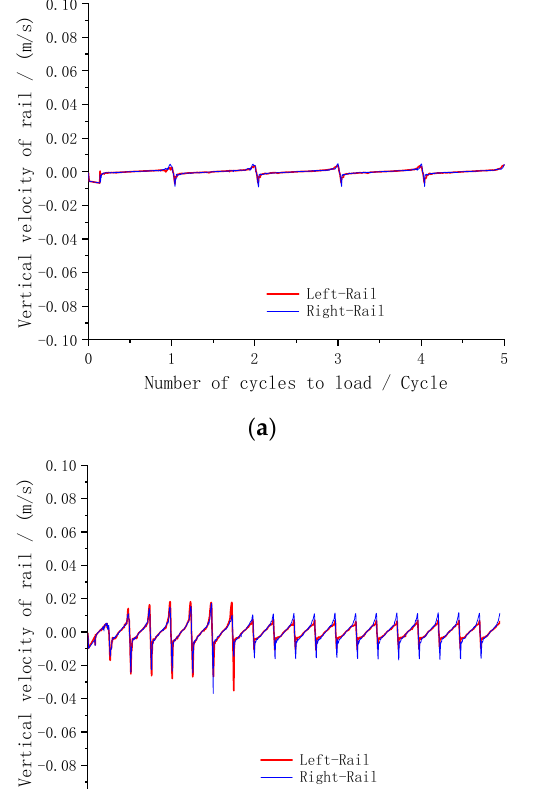
curves of the left and right rails changed periodically with the cyclic load. The vertical displacement of the rail corresponding to 5 Hz was the smallest, approximately 2 mm. The vertical displacement value of the left and right strand rails corresponding to 50 Hz was the largest, close to 2.25 mm. The vertical displacement of the rail increased with the increase in the loading frequency, and the vertical displacement of the rail increased slowly with the increase in the number of cycles until it tended to a stable value.